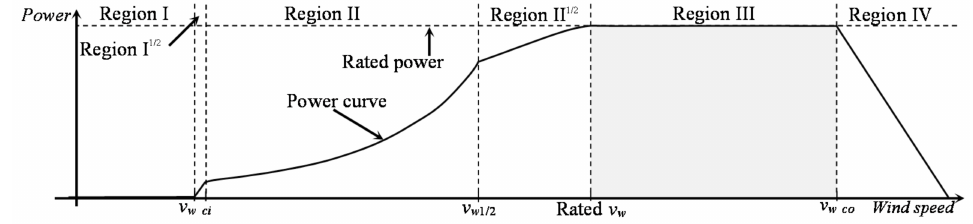
Figure 1. Operation regions of a variable-speed, variable-pitch, horizontal-axis wind